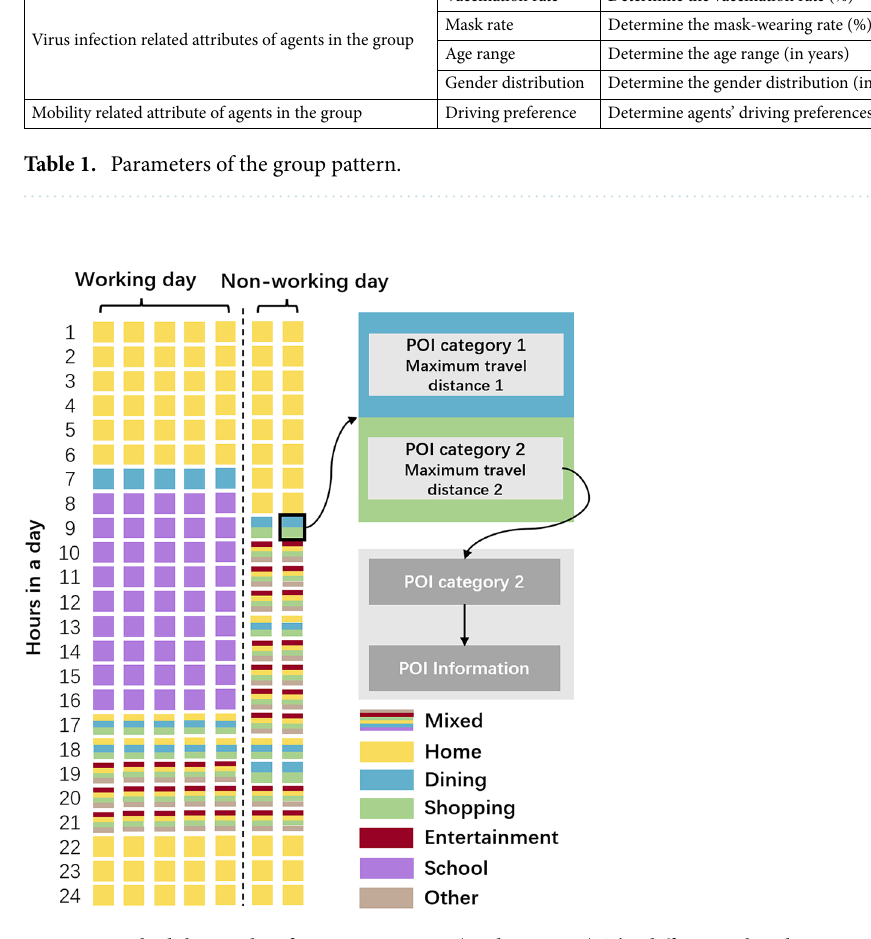
Figure 2. Schedule template for a certain group (student group). The different colored squares (brown square, green square, yellow square, etc.) represent an hour in the schedule template. For each square, there will be one or more categories inside, which represent the POI categories that such agent needs to go to in that hour. we use colors to distinguish the categories of